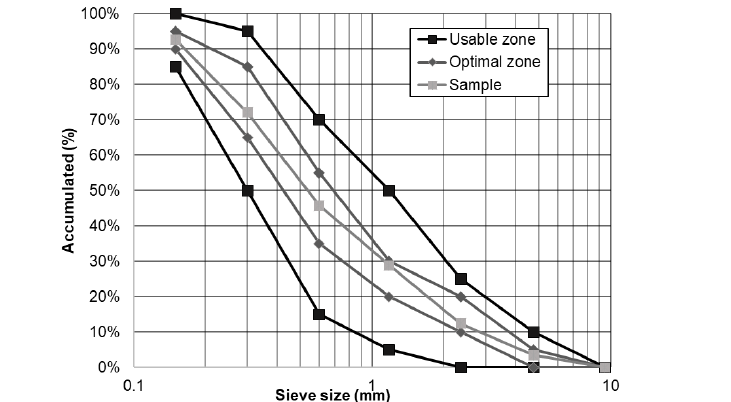
Figure 2. Particle size distribution of fine